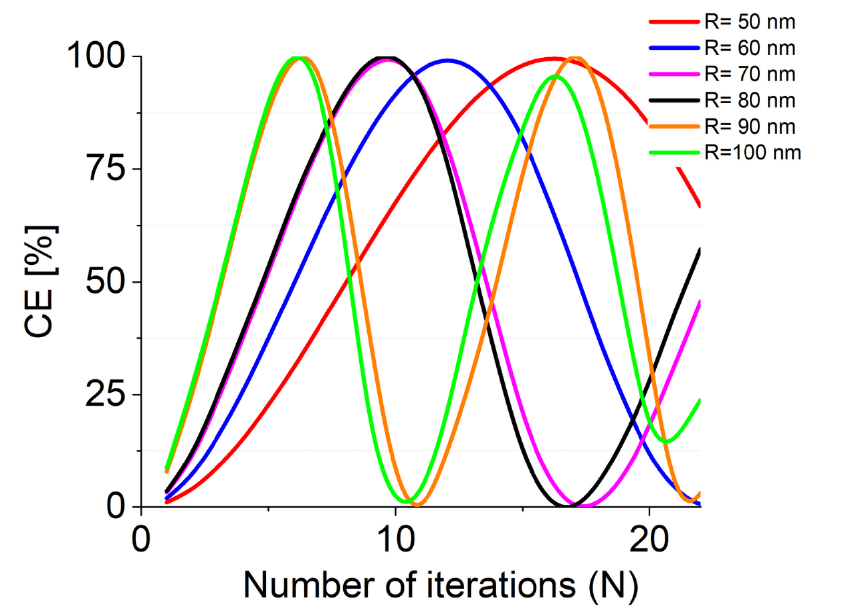
Figure 5. Calculated CE as a function of N, number of iterations required to achieve full TE–TM